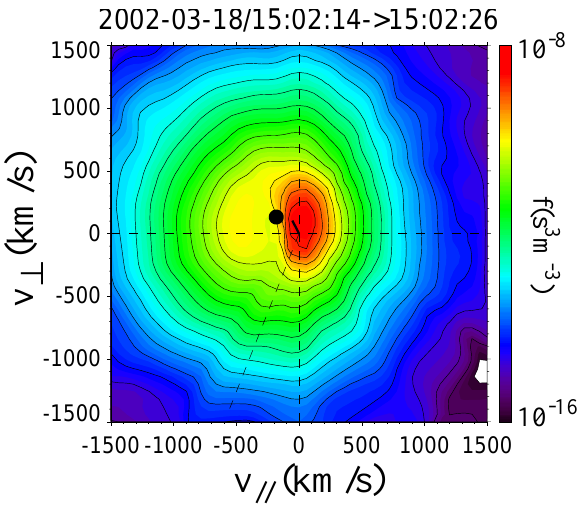
Fig. 9. Two dimensional cuts of the 3-D ion distributions in a tail- ward of cusp reconnection event on 18 March 2002 (Phan et al., Figure 9. 2-D cuts of the 3D ion distributions in a tailward of 2003) for comparison. The D-shape distribution, with the low- energy cutoff along a constant v // at the HT velocity, is clearly cusp reconnection event on 2002-03-18 [Phan et al., 2003] for comparison. The D-shape distribution, with the low-energy cutoff along a constant v at the HT velocity, is clearly present. //